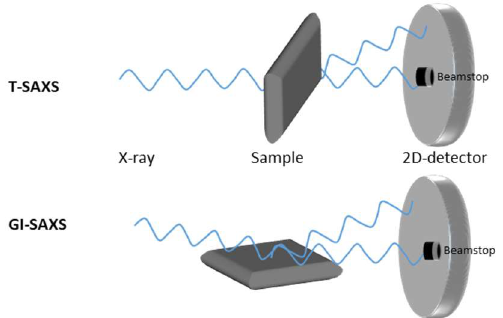
Figure 2. SAXS setup: Transmission (T)-SAXS and gracing incidence (GI)-SAXS measurement setup.